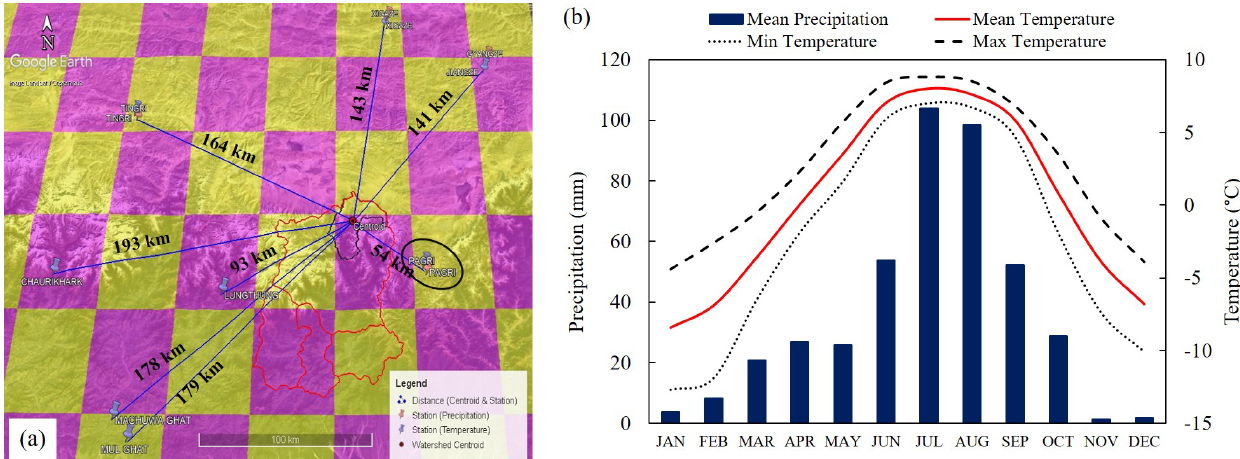
Figure 2. (a) Location of meteorological stations overlaid on Google Earth platform and their respective distance (km) to the centroid of the CCW. The red and blue place marks represent the individual stations for precipitation and temperature data presented in this study. The black oval represents Pagri Meteorological Station (PMS). Pink and yellow checked boxes represent the 0 . 5 ◦ × 0 . 5 ◦ gridded cells of Climatic Research Unit (CRU) data. (b) Climograph of the CCW, the Sikkim Himalaya, representing the mean monthly temperature and precipitation data from 1960 to 2013; data source: (http://www.cru.uea.ac.uk/data, last access: 13 June